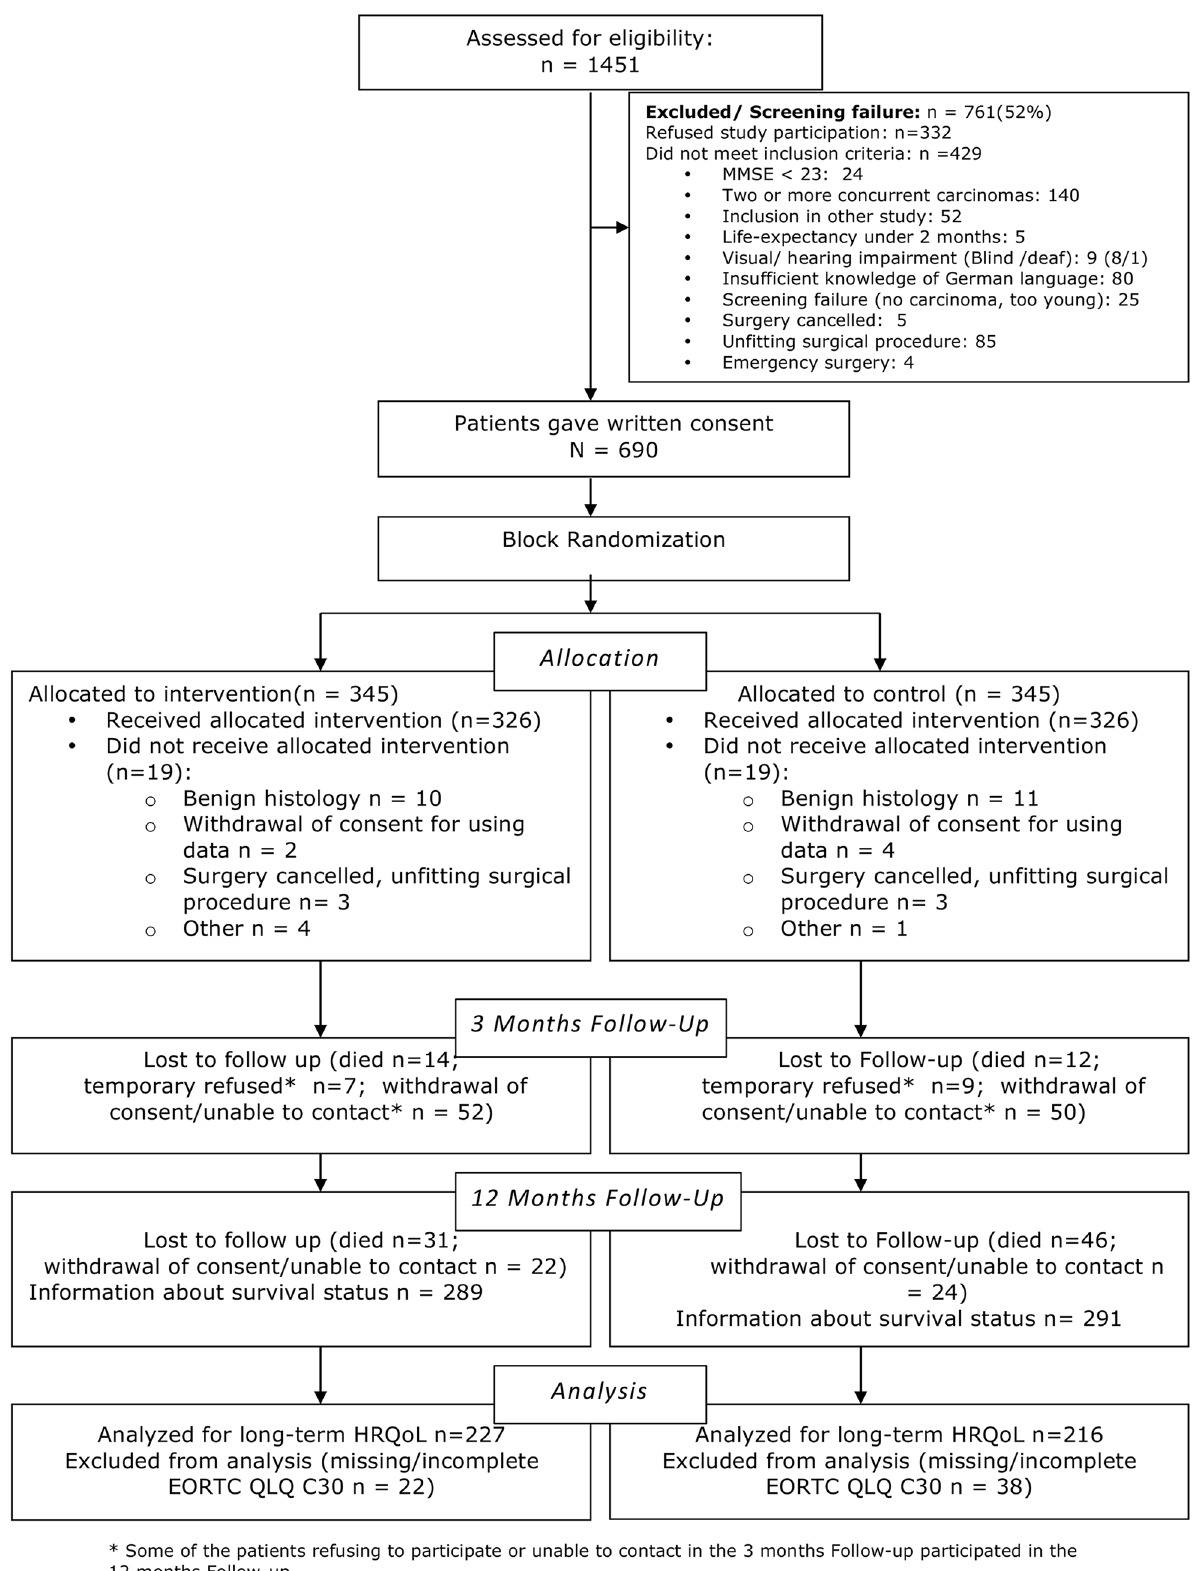
Fig 1. Study flow diagram. doi:10.1371/journal.pone.0137824.g001 PLOS ONE | DOI:10.1371/journal.pone.0137824 September 17,